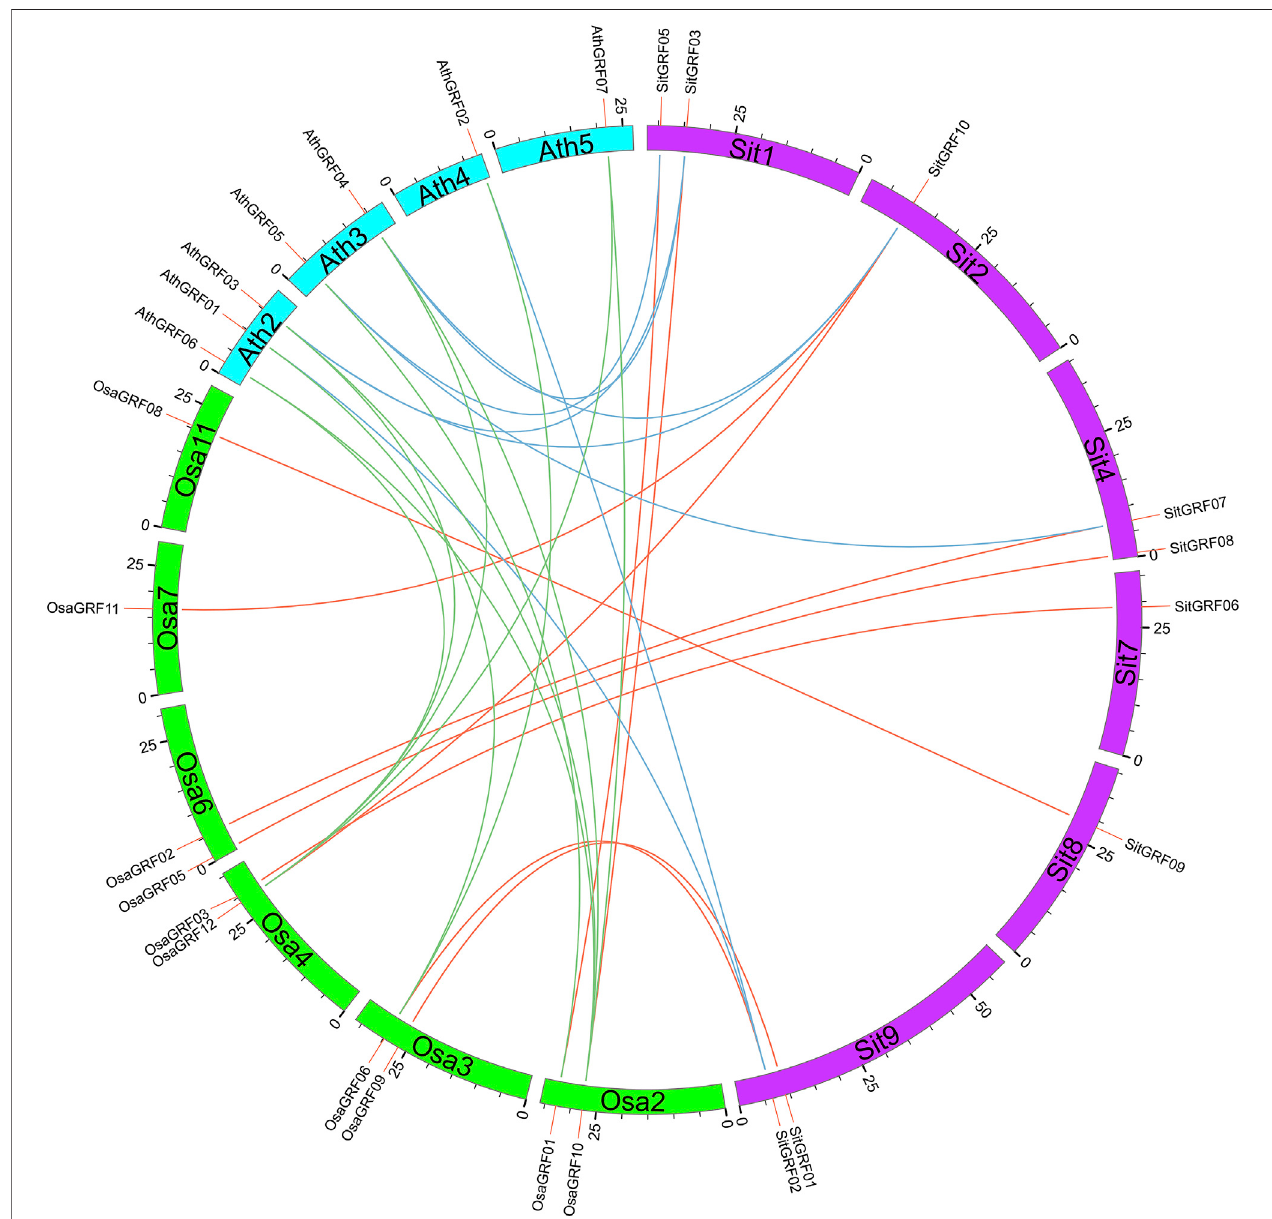
FIGURE 12 | Orthologs of GRF genes between foxtail millet and model plants. The orthologous GRF gene pairs between different species are linked by different colors.